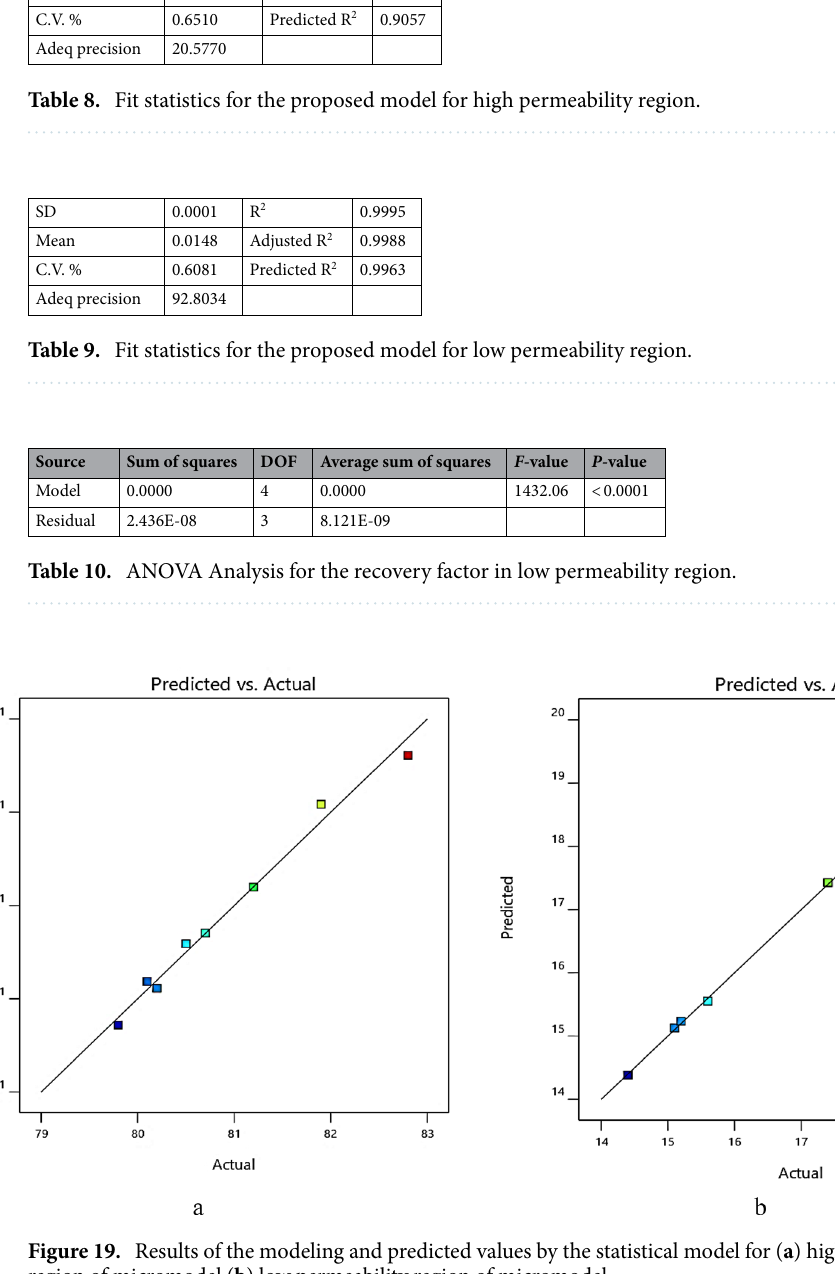
Figure 19a and b, represent the results of modeling and prediction of oil recovery factor based on the proposed statistical models for high and low permeability regions, respectively. As represented in these figures, most of the data are nested near the unit slope line curve which states the high accuracy of the proposed statistical model.